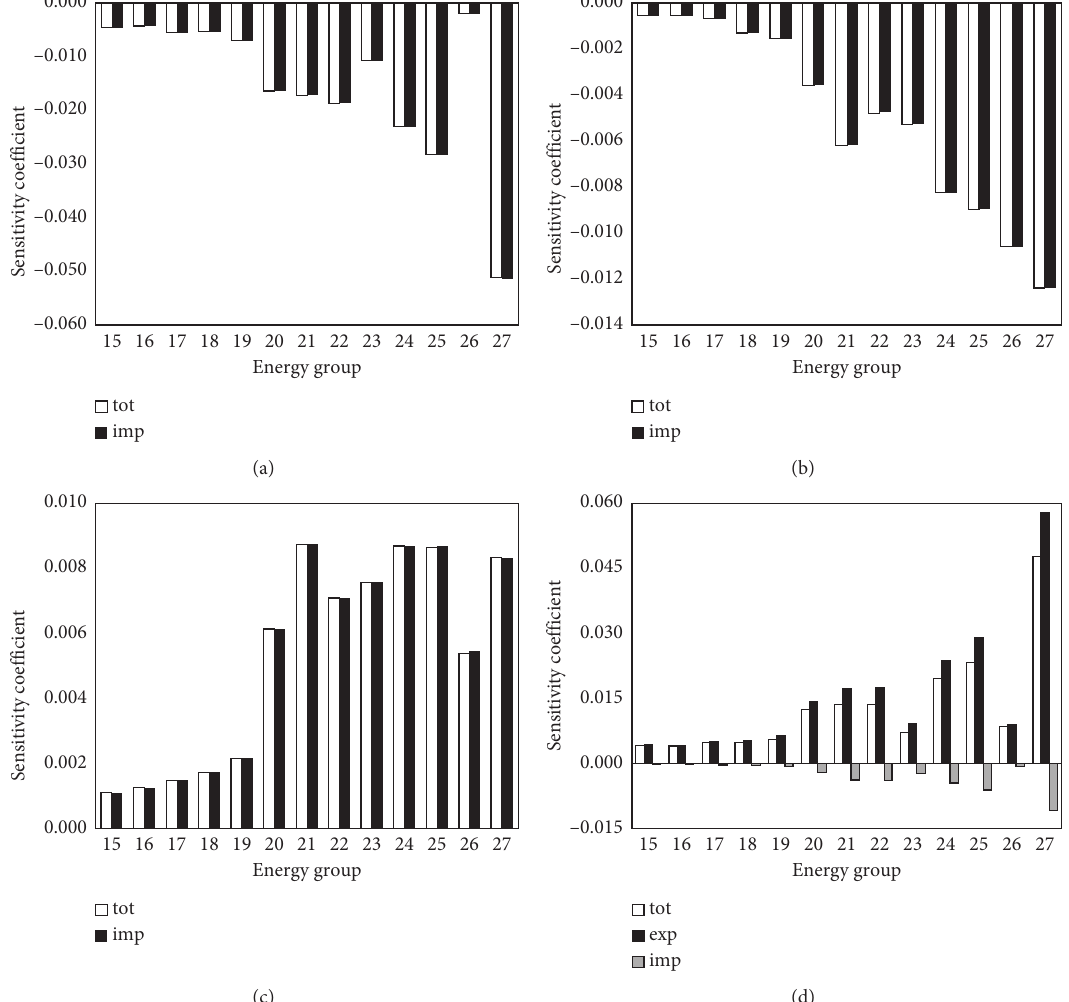
Figure 12: The total and implicit sensitivity coefficients of k (d) 1 H elastic